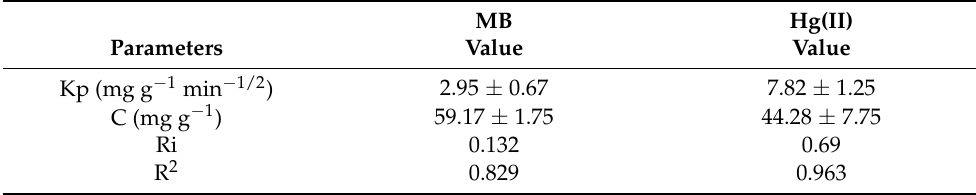
Table 2. Estimated parameters of the intraparticle diffusion (IPD) model at 298